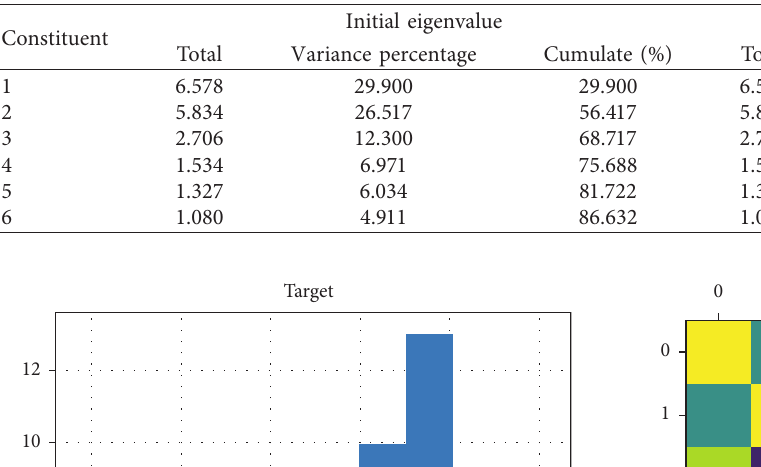
Table 5: Principal factor eigenvalues and cumulative contribution rates.